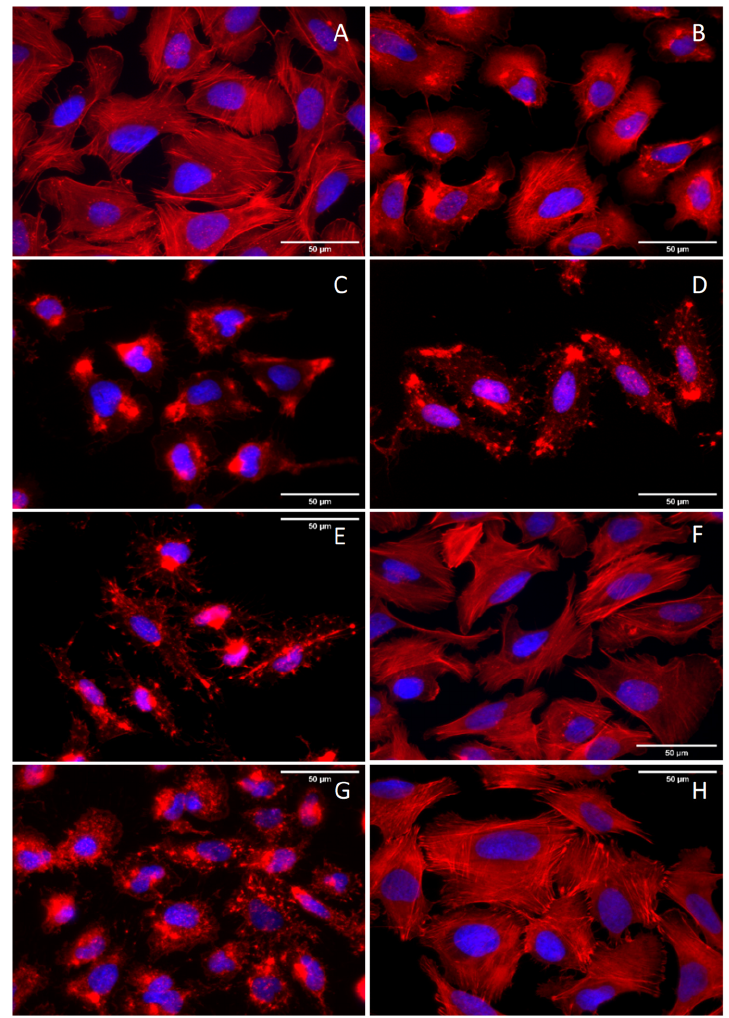
Figure 3. Overlay images of U2OS cells treated with varying concentrations of chaetoglobosin B ( A – E,G ) and DMSO as vehicle control ( F,H ) after one hour, the fixed and stained with a fluorescent phalloidin conjugate (Phalloidin–ATTO 594) and DAPI. Concentrations are as followed: 0.01 µ g / mL ( A ), 0.1 µ g / mL ( B ), 0.25 µ g / mL ( C ), 0.5 µ g / mL ( D ), 1 µ g / mL ( E ), and. 0.5 µ g / mL followed by